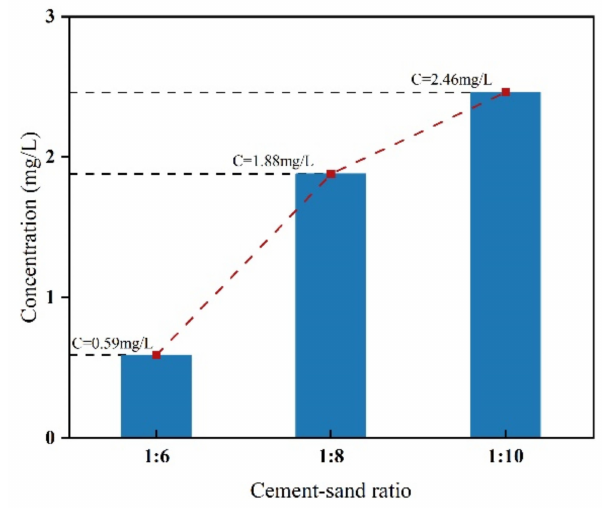
Figure 6. Toxicity leaching